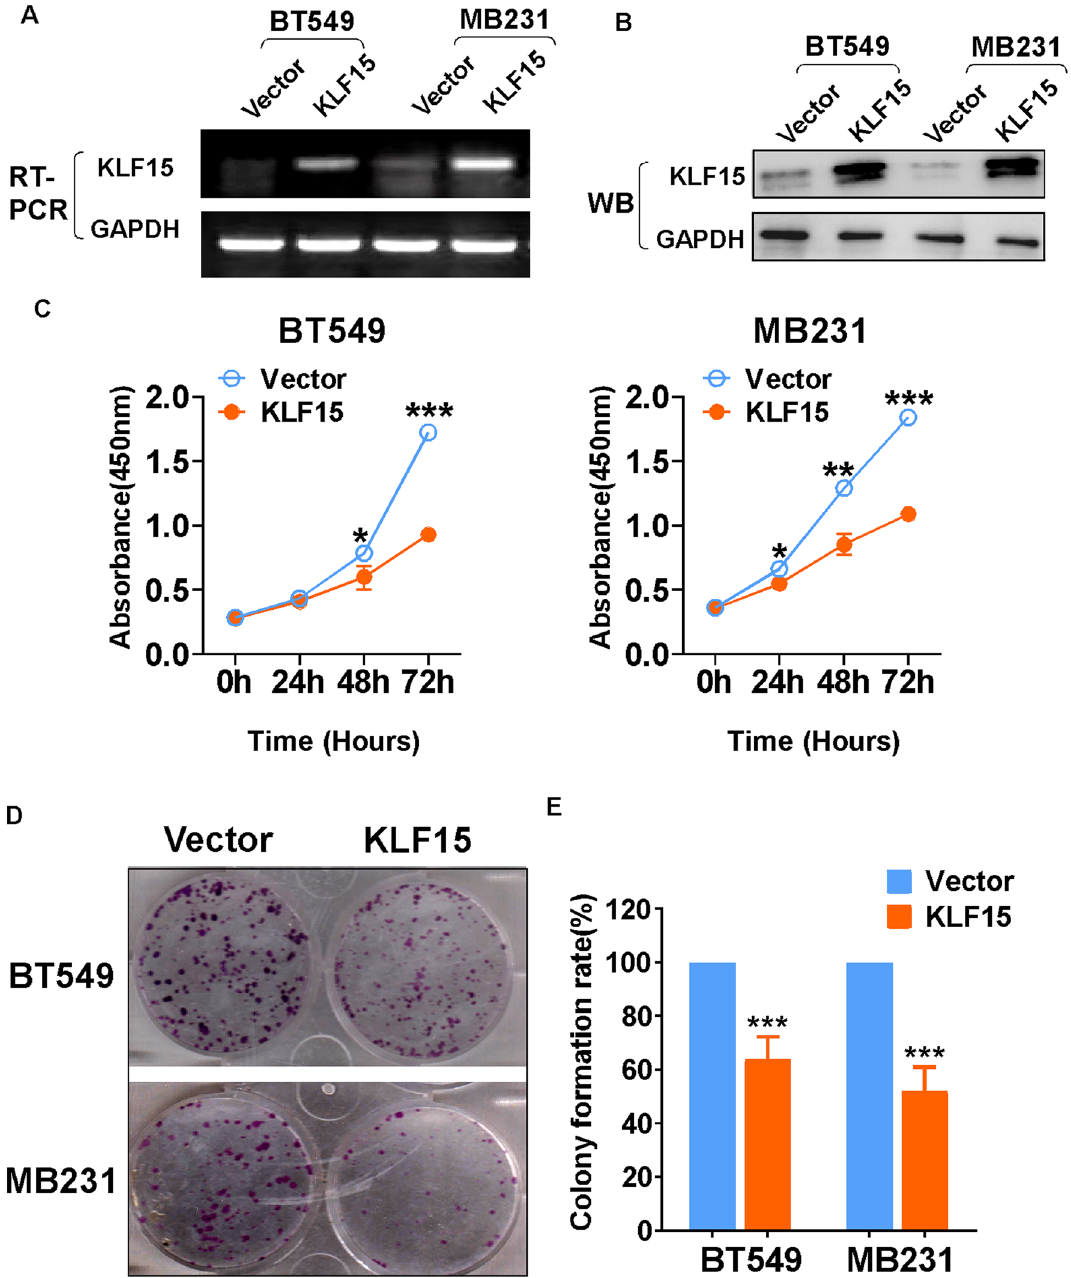
Figure 3. Overexpression of KLF15 inhibited the proliferation of TNBC breast cancer cells. ( A , B ) Validation of KLF15 overexpression by RT-PCR and Western blotting. ( C ) The capacity of cell proliferation was detected in MDA-MB231 and BT549 cells stably transfected with KLF15 or empty vector plasmid via CCK8 assay. ( D , E ) Representative images and histogram statistics of the colony-formation assay in vector- and KLF15-expressing MDA-MB231 and BT549 cells. * p < 0.05, ** p < 0.01, *** p < 0.001. All experiments were performed in triplicate,